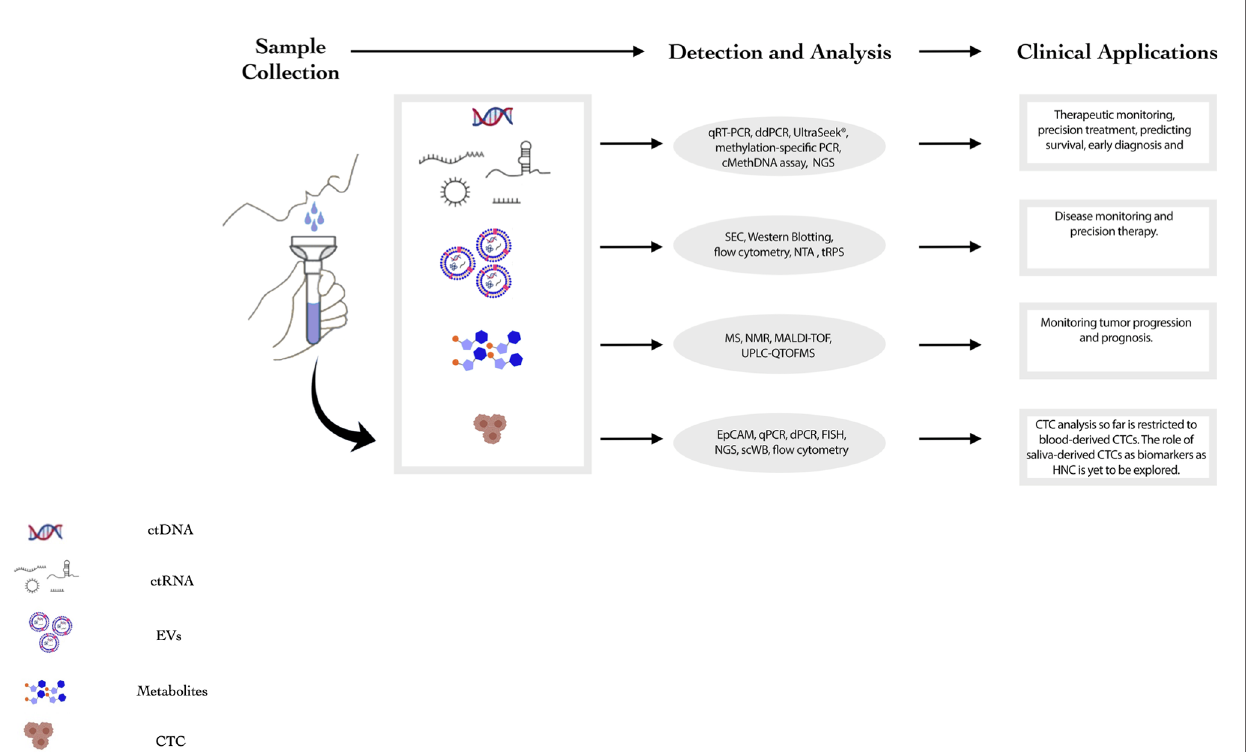
FIGURE 1 | Summary of salivary components that can potentially act as biomarkers for HNC. This fi gure summarizes the current landscape of salivary components that may act as biomarkers for HNC. The detection and analysis techniques and clinical applications for each component are mentioned in the fi gure. ( NMR: Nuclear Magnetic Resonance, MS: Mass Spectrometry, HNC: Head and Neck Cancer, ddPCR: Droplet Digital Polymerase Chain Reaction, qPCR: quantitative Polymerase Chain Reaction, NGS: Next Generation Sequencing, SEC: Size-Exclusion Chromatography, NTA: Nanoparticle Tracking